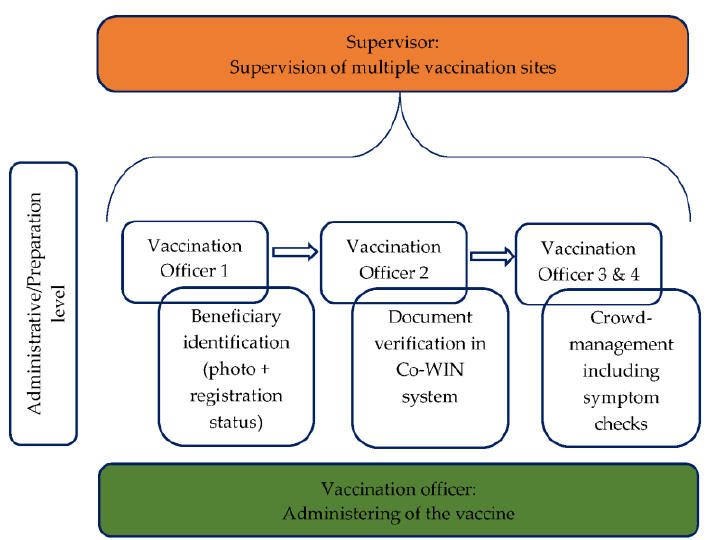
Figure 1. Roles of vaccination team. Own illustration, data compiled from Ministry of Health and Family Welfare Government of India [24].